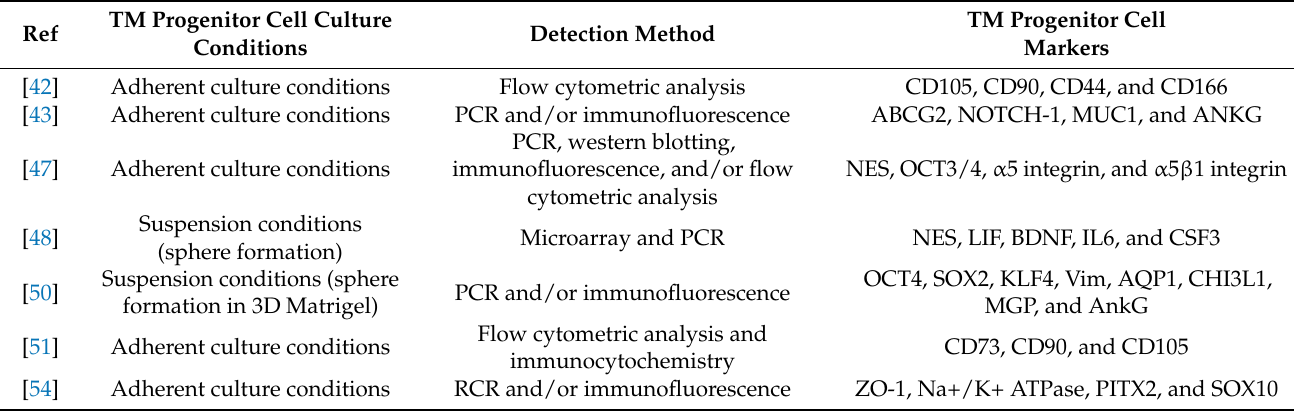
Table 2. Identification and detection methods of specific TM progenitor markers in vitro under different progenitor cell culture conditions.